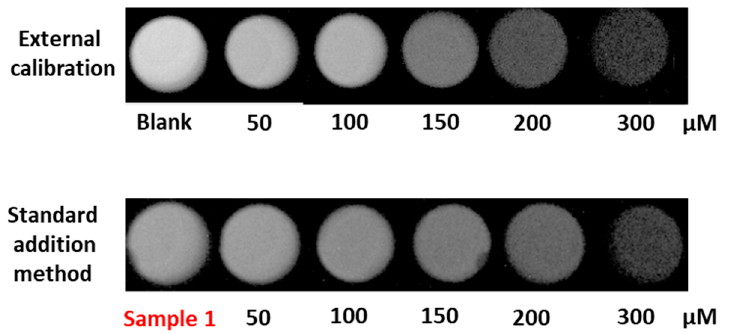
Figure 6. Comparison of the CL image for external calibration and standard addition method in sample 1. sample